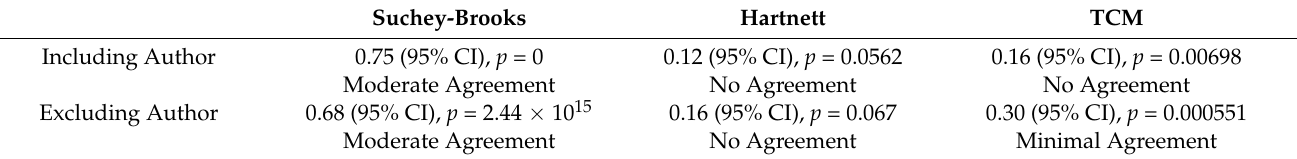
Table 12. Fleiss’ Kappa comparisons by estimation method, observer subset (females, n =